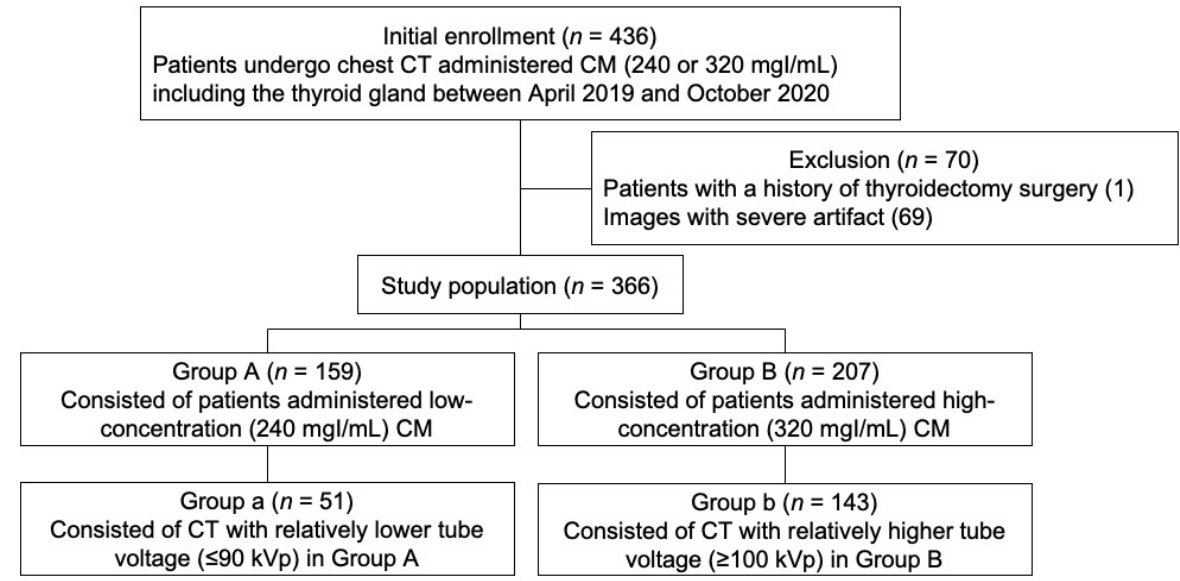
Figure 1. Flowchart of the enrollment of the study population, CT = computed tomography, CM = contrast media.